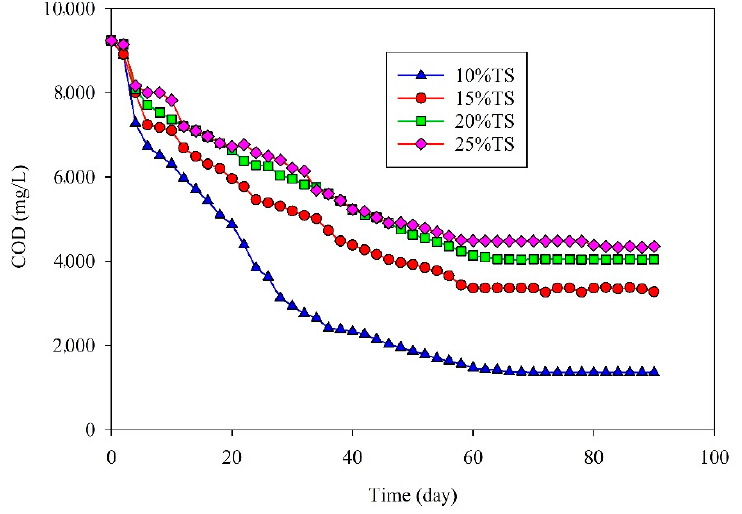
Figure 2. Effect of different percentages of total solids (TS) on delignified C/N 25 (g/g) biogas chemical oxygen demand (COD).